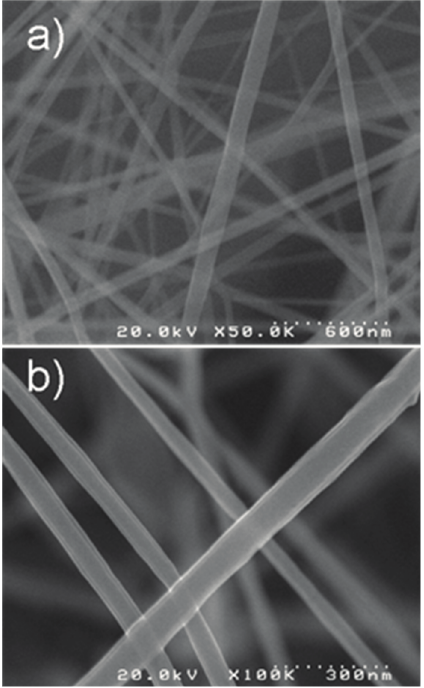
Figure 1. ( a ) Pulp cellulose-ESNW (scale bar, 600 nm); ( b ) Cotton cellulose-ESNW (scale bar, 300 nm). Reproduced from [44] with permission of SAGE Publications,